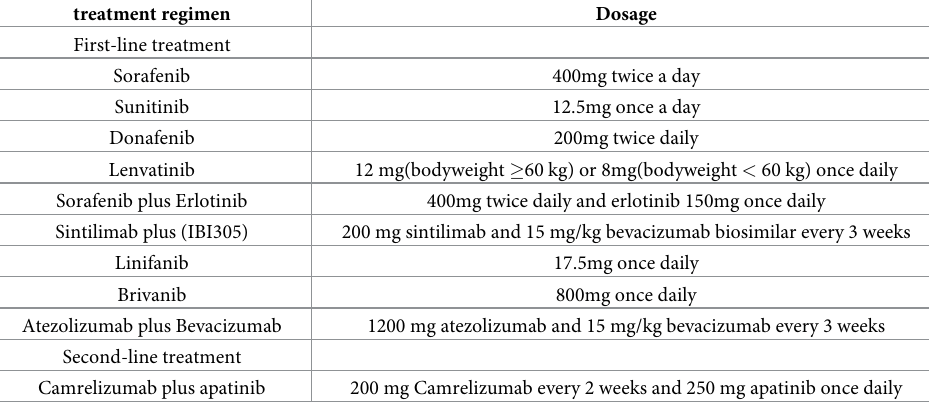
Table 1. Dosage of treatment